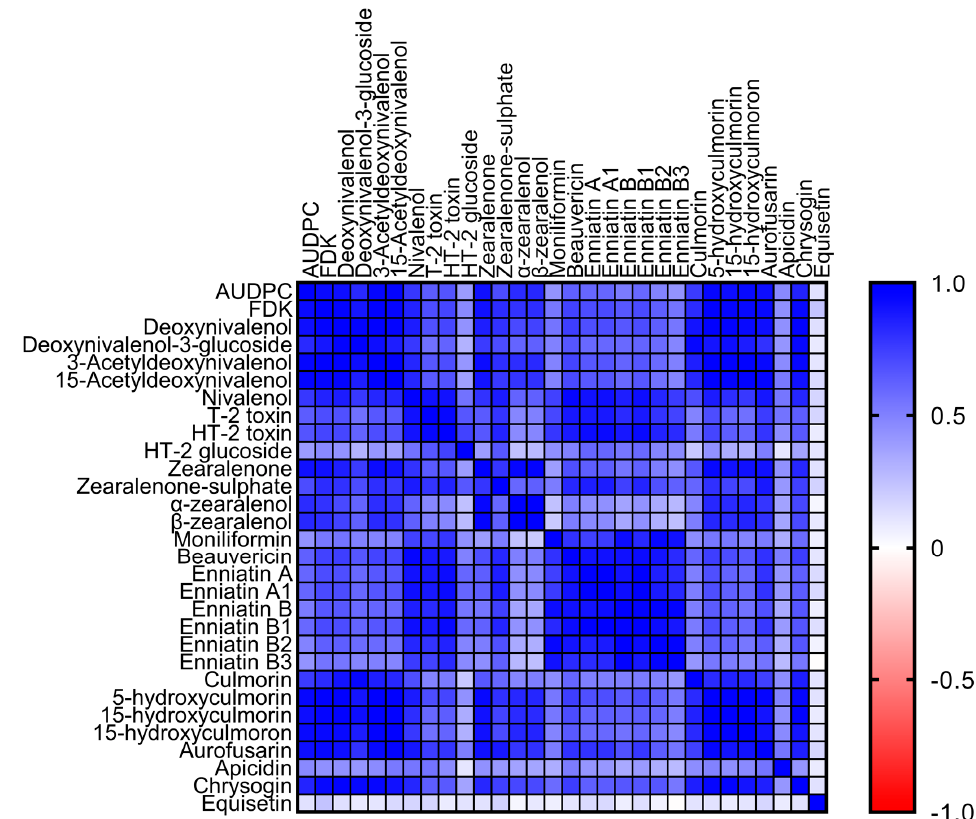
Figure 4. Heatmap presenting Pearson correlation matrix of area under the disease progress curve (AUDPC), Fusarium damaged kernels (FDK) and 28 Fusarium mycotoxins/metabolites in 36 wheat genotypes. Pearson correlation r values were determined using GraphPad Prism 9.4.1, San Diego, CA, USA. Colors are added for better visualization. The colors span from dark blue to dark red, where dark blue denotes a r value of 1, and dark red indicates a r value of − 1.